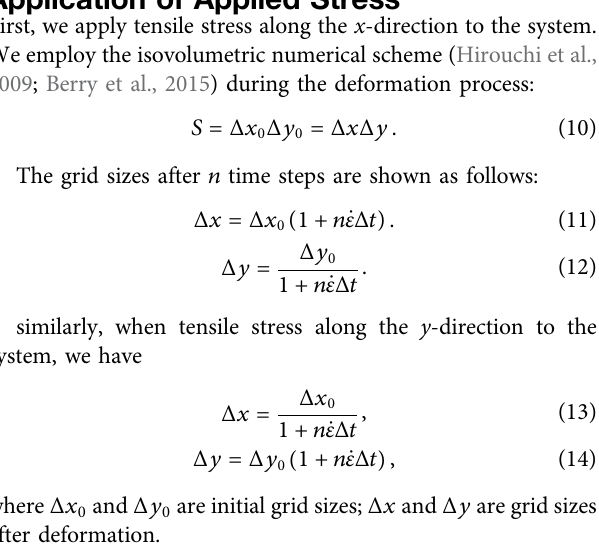
Frontiers in Materials |